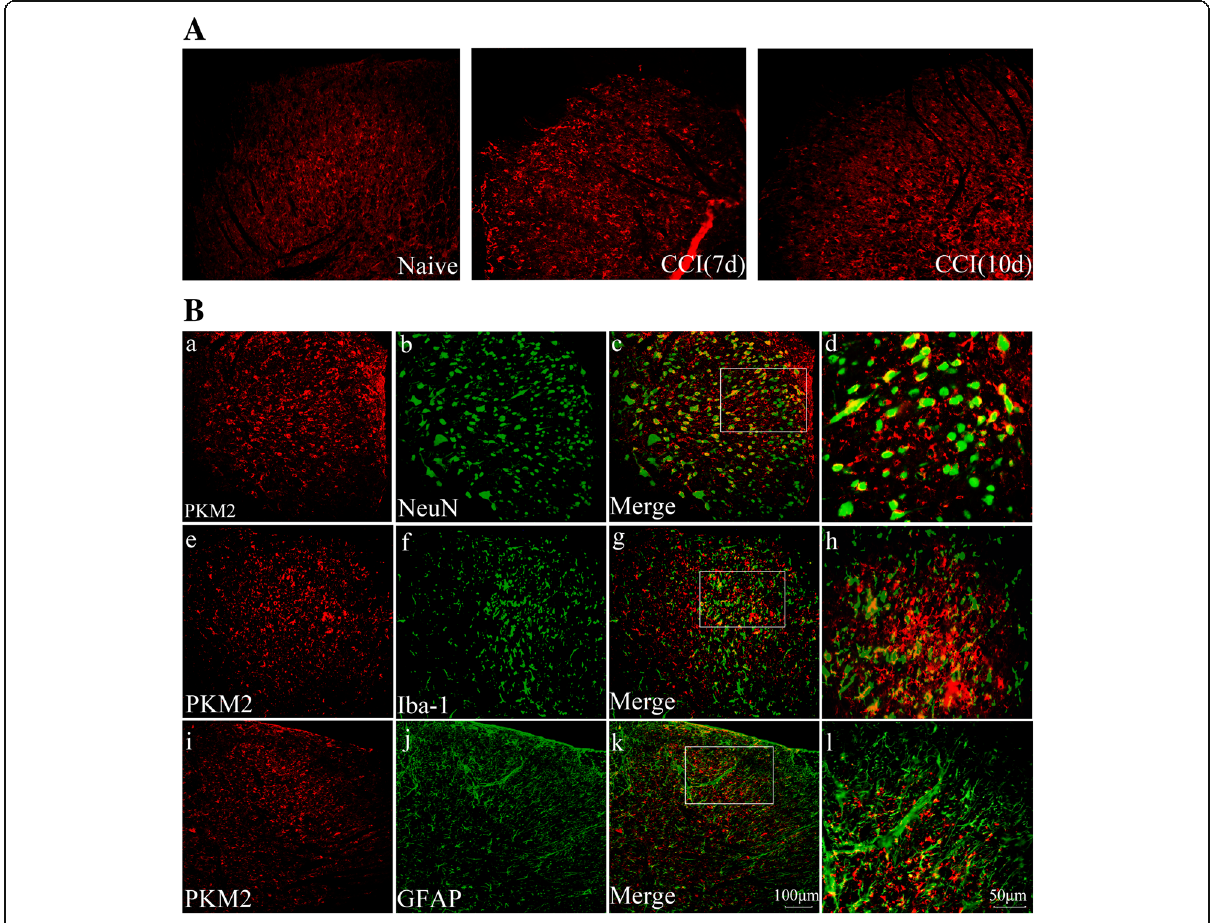
Fig. 2 Expression and distribution of PKM2 in spinal cord dorsal horn after CCI. A Immunofluorescence showed that expression of PKM2 (red) was increased at day 7 and day 10. B Double staining showed that PKM2 co-localized with neuron marker NeuN (a-d), microglia marker Iba-1 (e-h), and astrocyte marker GFAP